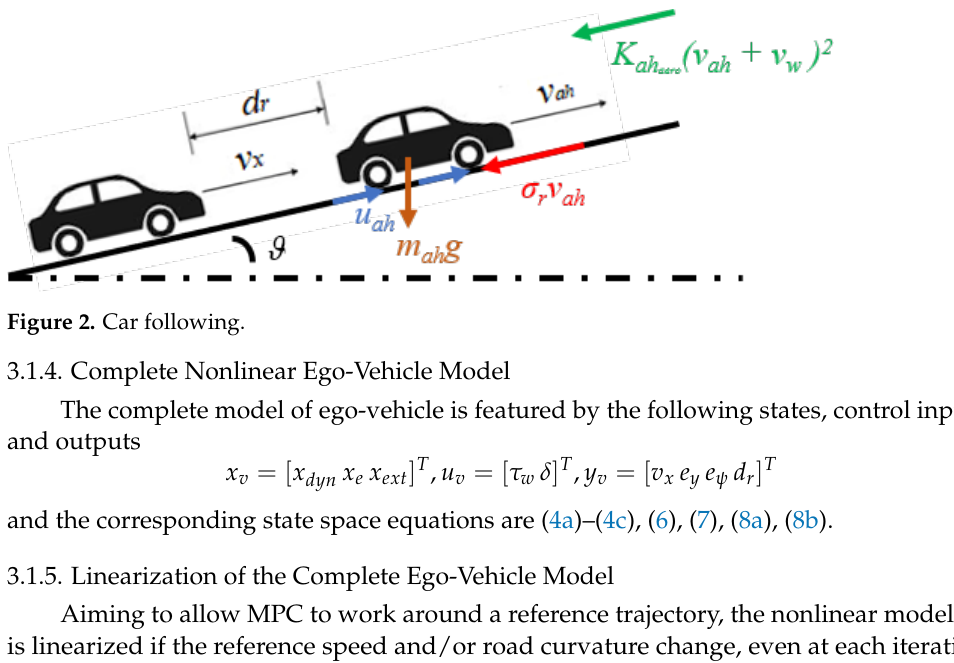
Figure 2. Assuming the availability of a Smart Road, this model takes into account the road